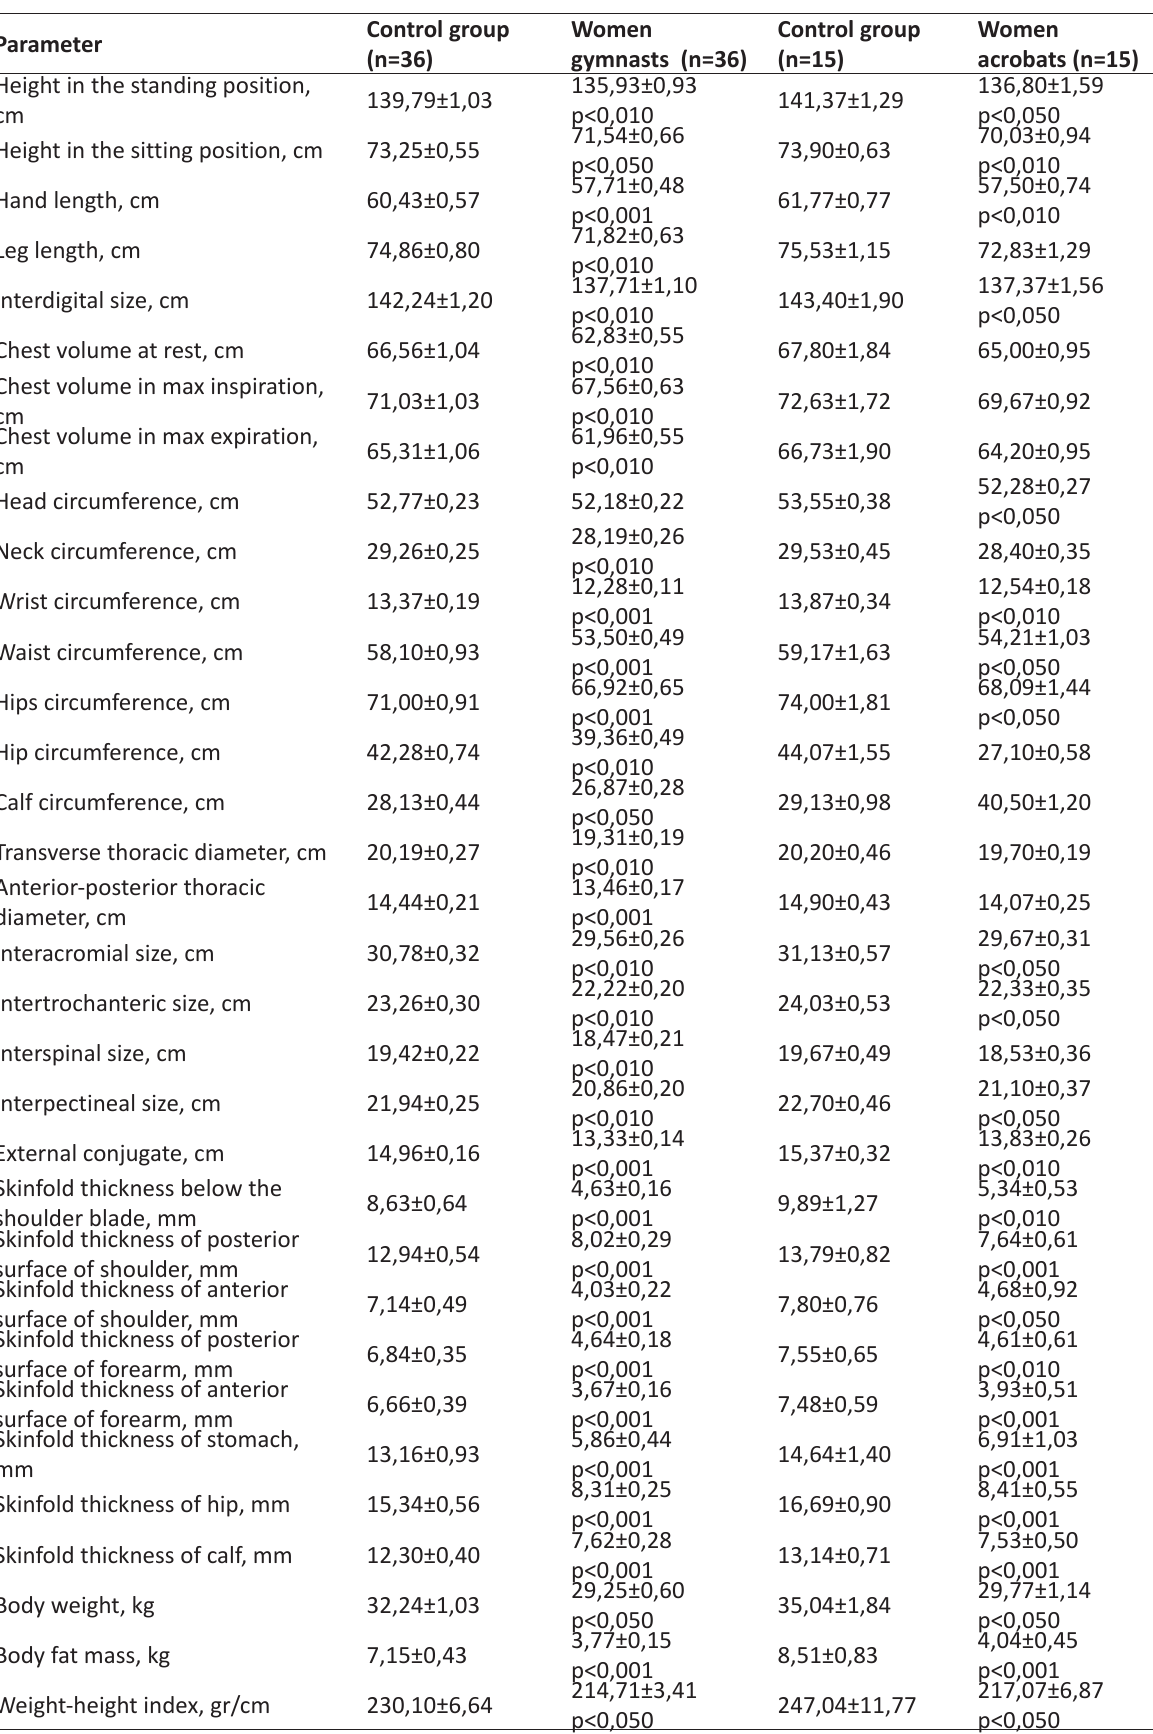
Table 1. Statistically significant differences of parameters (M±m) of 10-year-old athletes and non-athletes physical